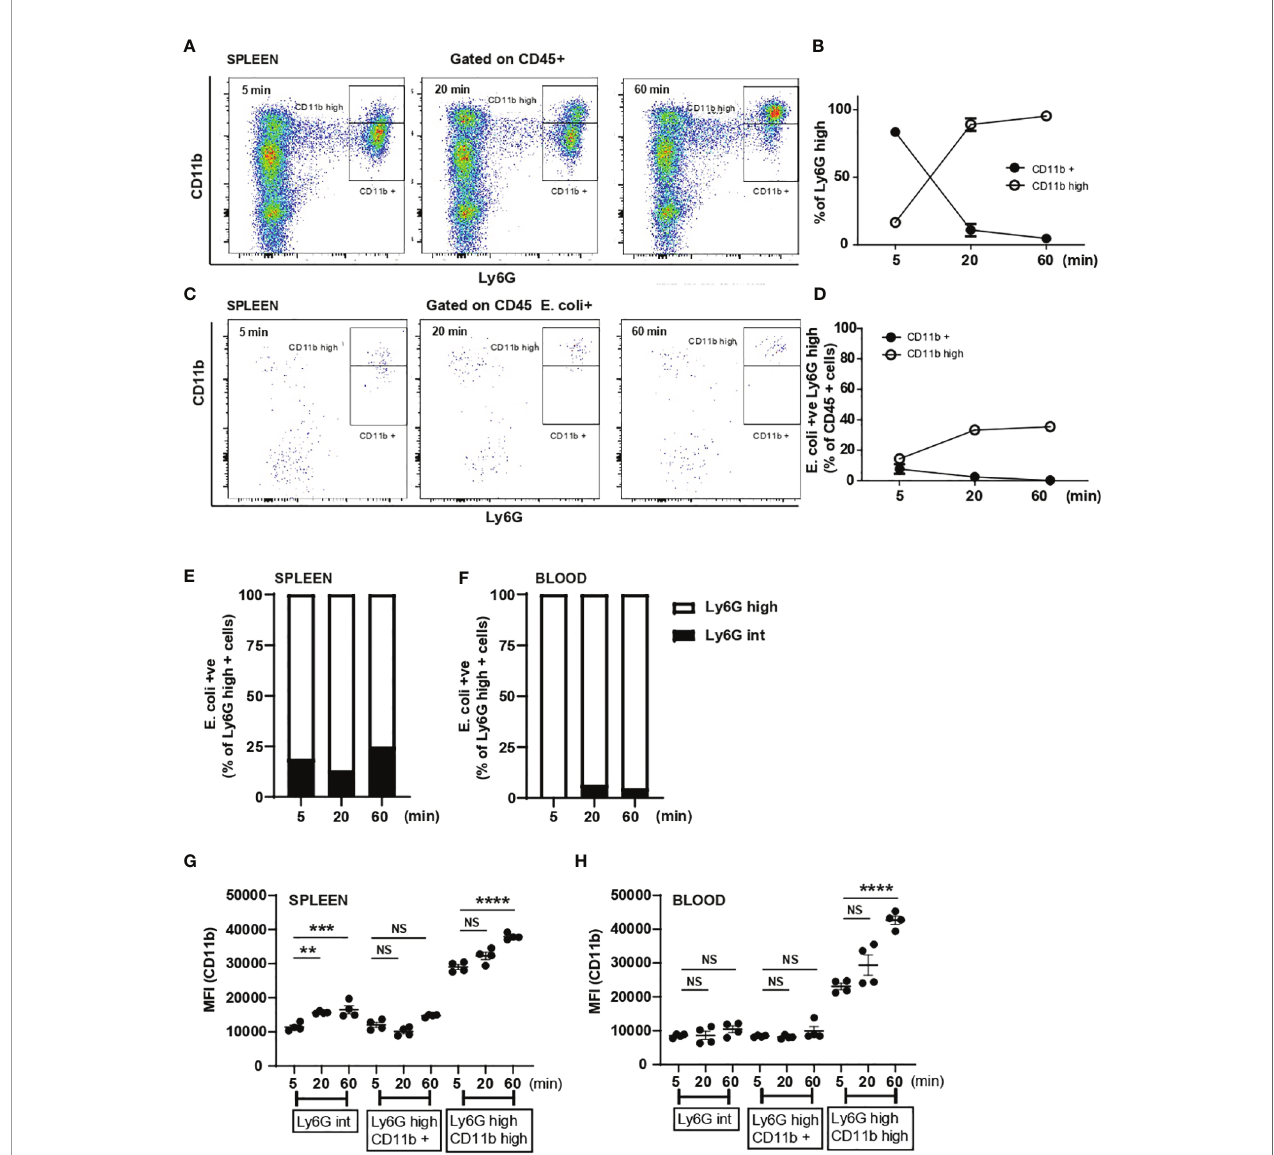
FIGURE 4 | Splenic neutrophils activation and Ly6G int and Ly6G high contribution to systemic E . coli recognition. (A) Flow cytometry analysis of splenic neutrophils 5, 20 and 60 min after i.v. injection of E. coli , representative of two independent experiments. (B) % of Ly6G high CD11b + and Ly6G high CD11b high neutrophils was calculated 5, 20 and 60 min post i.v. injection of heat-inactivated E. coli , (N=4 mice/timepoint). (C) Flow cytometry analysis of E. coli -positive splenic cells 5, 20 and 60 min after i.v. injection of E. coli , representative of two independent experiments. (D) E. coli -positive neutrophils as % of CD45+ cells were calculated 5, 20 and 60 min post i.v. injection of heat-killed E. coli , (N=4 mice/timepoint). (E) % of Ly6G int and Ly6G high of total E. coli-positive splenic neutrophils at 5, 20 and 60 min post challenge, (N=4 mice/timepoint). (F) % of Ly6G int and Ly6G high of total E. coli-positive circulating neutrophils at 5, 20 and 60 min post challenge, (N=4 mice/ timepoint). (G) Median fl uorescent intensity (MFI) (anti-CD11b fl uorophore) on splenic Ly6G int , Ly6G high CD11b + and Ly6G high CD11b high , one-way ANOVA, Tukey ’ s multiple comparison test, two independent experiments, (N=4 mice/group). (H) Median fl uorescent intensity (MFI) (anti-CD11b fl uorophore) expression on circulating Ly6G int , Ly6G high CD11b + and Ly6G high CD11b high , one-way ANOVA, Tukey ’ s multiple comparison test, two independent experiments, (N=4 mice/group). P < 0.01 **, P < 0.001 ***, P < 0.0001 ****, NS, non signi fi